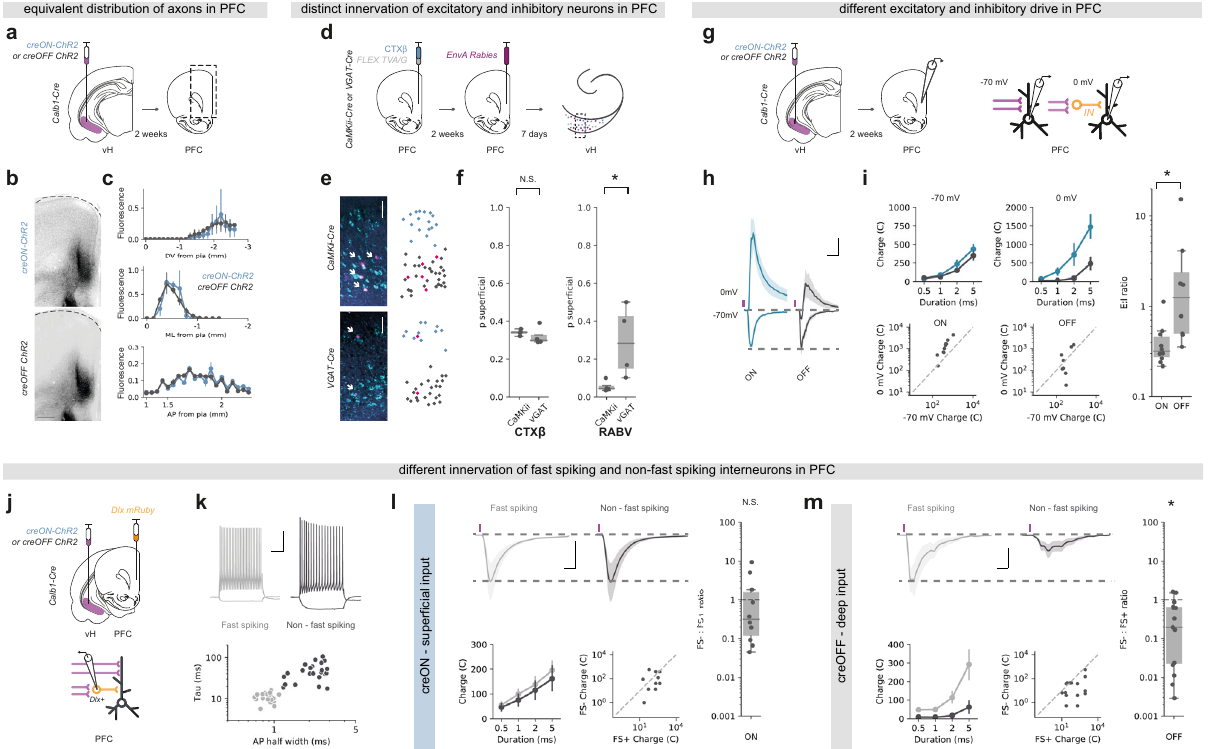
Fig. 4 Super fi cial and deep vH-PFC neurons connect differentially in PFC. a Strategy to label axons from super fi cial (creON) and deep (creOFF) layers for visualization in PFC. b Example images of super fi cial (top) and deep (bottom) layer vH axon terminals in PFC. Scale bar = 100 µ m. Images representative of slices from 4 injections. c Distribution of super fi cial (creON, blue) and deep (creOFF, grey) layer axon terminals in PFC along the DV, ML and AP brain axes. Note the distribution for both layers is equivalent (repeated measures ANOVA, main effect of group, DV: F (1,6) = 0.31, p = 0.599; ML: F (1,6) = 0.10, p = 0.77; AP: F (1,6) = 0.03, p = 0.59; n = 4 injections). See supplementary statistics table for more information. d Strategy to label neurons projecting to inhibitory and excitatory neurons in PFC. e Left, transverse slice of hippocampus labelled with CTX β (cyan) and rabies (magenta) after tracing from excitatory ( CaMKii , top ) or inhibitory (VGAT , bottom ) neurons in PFC. Note the restriction of rabies labelling from excitatory neurons to the deep layer. Scale bars = 100 µ m. Right , product of GMM clustering (see Fig. 1 and “ Methods ” ) of all cells in the example image. Super fi cial layer is shown in blue, deep layer in black and rabies labelled cells superimposed in magenta. f Proportion of CTX β positive neurons (left) and rabies positive neurons (right) in the super fi cial layer for both experiments ( CaMKii , vH excitatory and VGAT , vH inhibitory ). Note equivalent distribution of CTX β across both conditions (two-sided Mann Whitney, U = 4, N.S. p = 0.3), but a marked absence of neurons projecting to excitatory PFC neurons (RABV: CaMKii ) in the super fi cial layer (two- sided Mann Whitney, U = 16, * p = 0.03, n = 4 injections). g Strategy to record PFC excitatory input, or inhibitory input mediated via feedforward interneurons (orange). h Responses to super fi cial (blue) or deep (grey) hippocampal inputs at -70 mV (EPSCs) and 0 mV (IPSCs) in deep layer PFC neurons. Purple tick indicates light pulse. Scale bar = 20 ms and 0.5 (fold response amplitude at – 70 mV, which is normalized to 1). i Left , summary of amplitude of super fi cial (creON, blue) and deep (creOFF, grey) responses at – 70 mV and 0 mV to increasing durations of light pulse (top), and recorded amplitudes of individual responses at – 70 mV and 0 mV to super fi cial (ON) and deep (OFF) input at 5 ms (bottom). Right, summary of the ratio of responses recorded at – 70 mV: 0 mV. Higher values mean input is biased to excitation, low values towards inhibition. Note log scale. Input from super fi cial neurons has a greater inhibitory contribution than that of deep neurons (two sided Mann Whitney, U = 10, p = 0.006, n = 10 neurons 4 from mice (sup), 8 neurons from 3 mice (deep)). j Strategy to record input from the two layers of vH onto identi fi ed interneurons in PFC. k Top , example current clamp recordings from fast-spiking (FS + , grey) and non-fast-spiking (FS-, black) interneurons in PFC. Bottom, summary showing clustering of recorded neurons into two groups based on membrane time constant and action potential half width. l Top, responses to super fi cial (creON) input at – 70 mV (EPSCs) onto neighboring fast spiking (grey) or non-fast spiking interneurons (black). Scale bar = 10 ms, 200 pA. Bottom, summary of amplitude of FS + and FS- responses to increasing durations of light pulse (left), and amplitudes of individual pairs at 5 ms ( right ). Right , summary of the ratio of FS-: FS + . Higher values mean input is biased to non-fast spiking (FS-), low values towards fast spiking (FS + ) neurons. Note log scale. Super fi cial input is equivalent onto FS + and FS- neurons in PFC (two-sided Wilcoxon paired test, W = 35, N.S. p = 0.49, n = 10 pairs from 5 mice). m As in ( l ) but for deep (creOFF) input. Deep input is biased towards fast spiking (FS + ) interneurons in PFC (two-sided Wilcoxon paired test, W = 111, * p = 0.02, n = 15 pairs from 4 mice). Box plots show median, 75th (box) and 95th (whiskers) percentile. Line plots show mean (line) and SEM (shading and error bars).